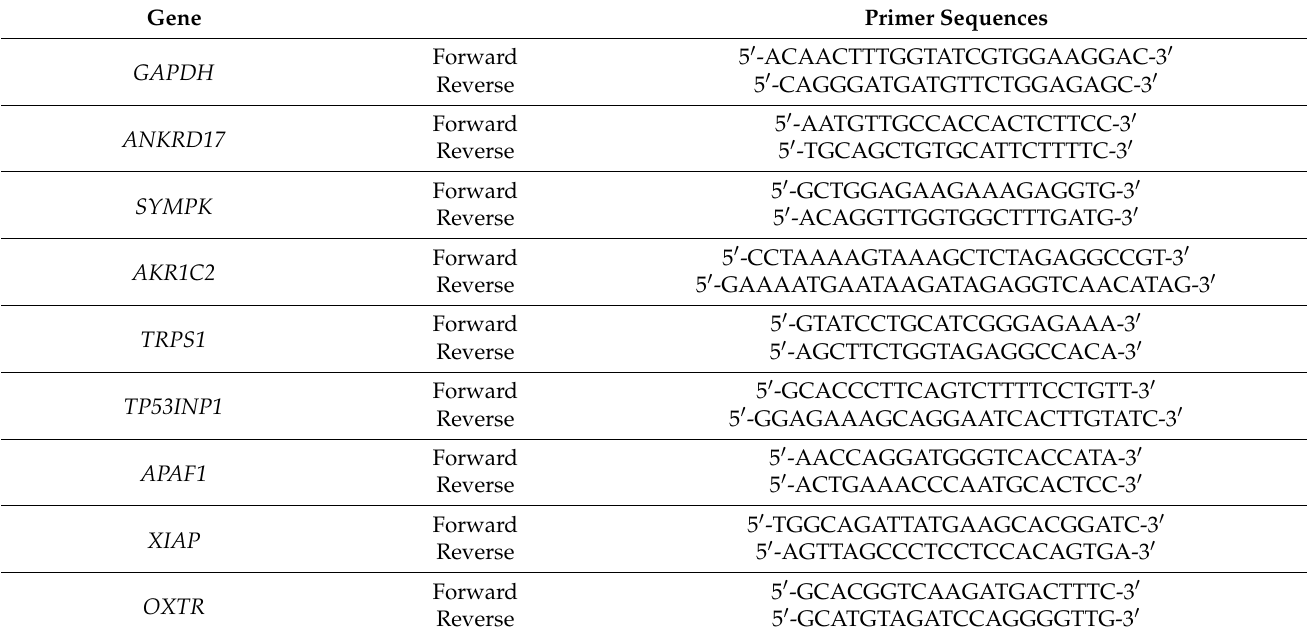
Table 3. Sequence of primers for gene expression analysis by